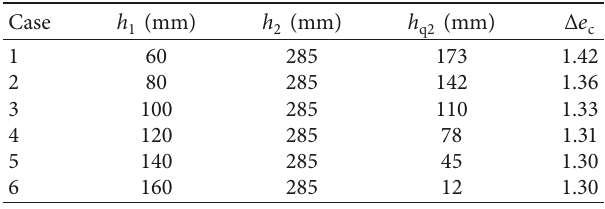
Table 12: Differential protection factors of FC-RPC targets.